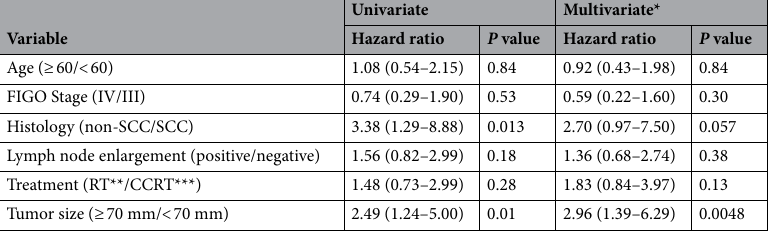
Table 2. Correlation between clinico-pathological factors and progression free survival in locally advanced cervical cancer patients. *Cox proportional hazards regression analysis, **Radiation therapy, ***Concurrent